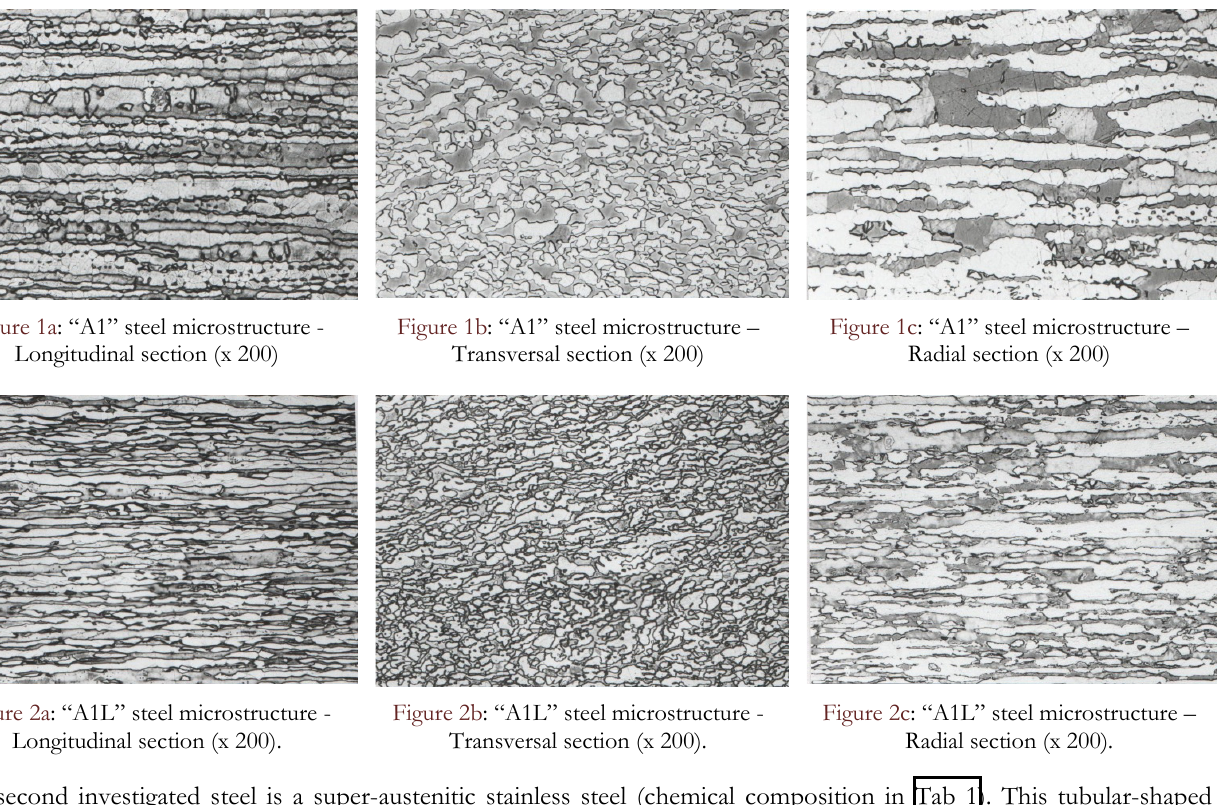
Figure 2a: “A1L” steel microstructure - Longitudinal section (x 200).